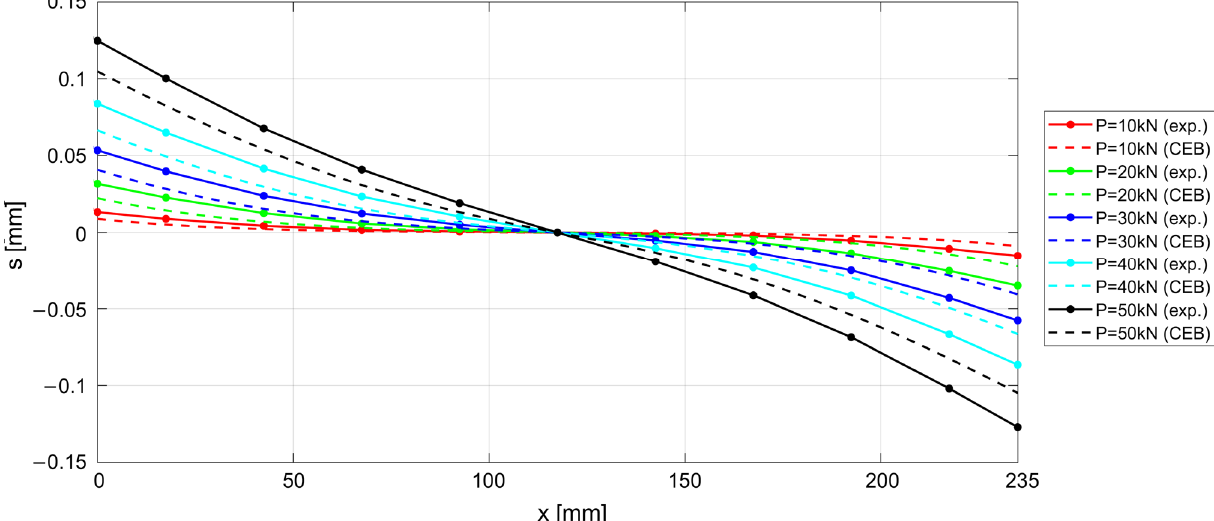
Figure 18. Experimental and numerical s − x for increasing load P .